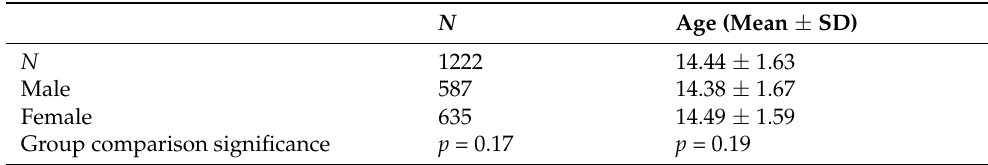
Table 1. Sample characteristics, number (N), and age mean and standard deviation